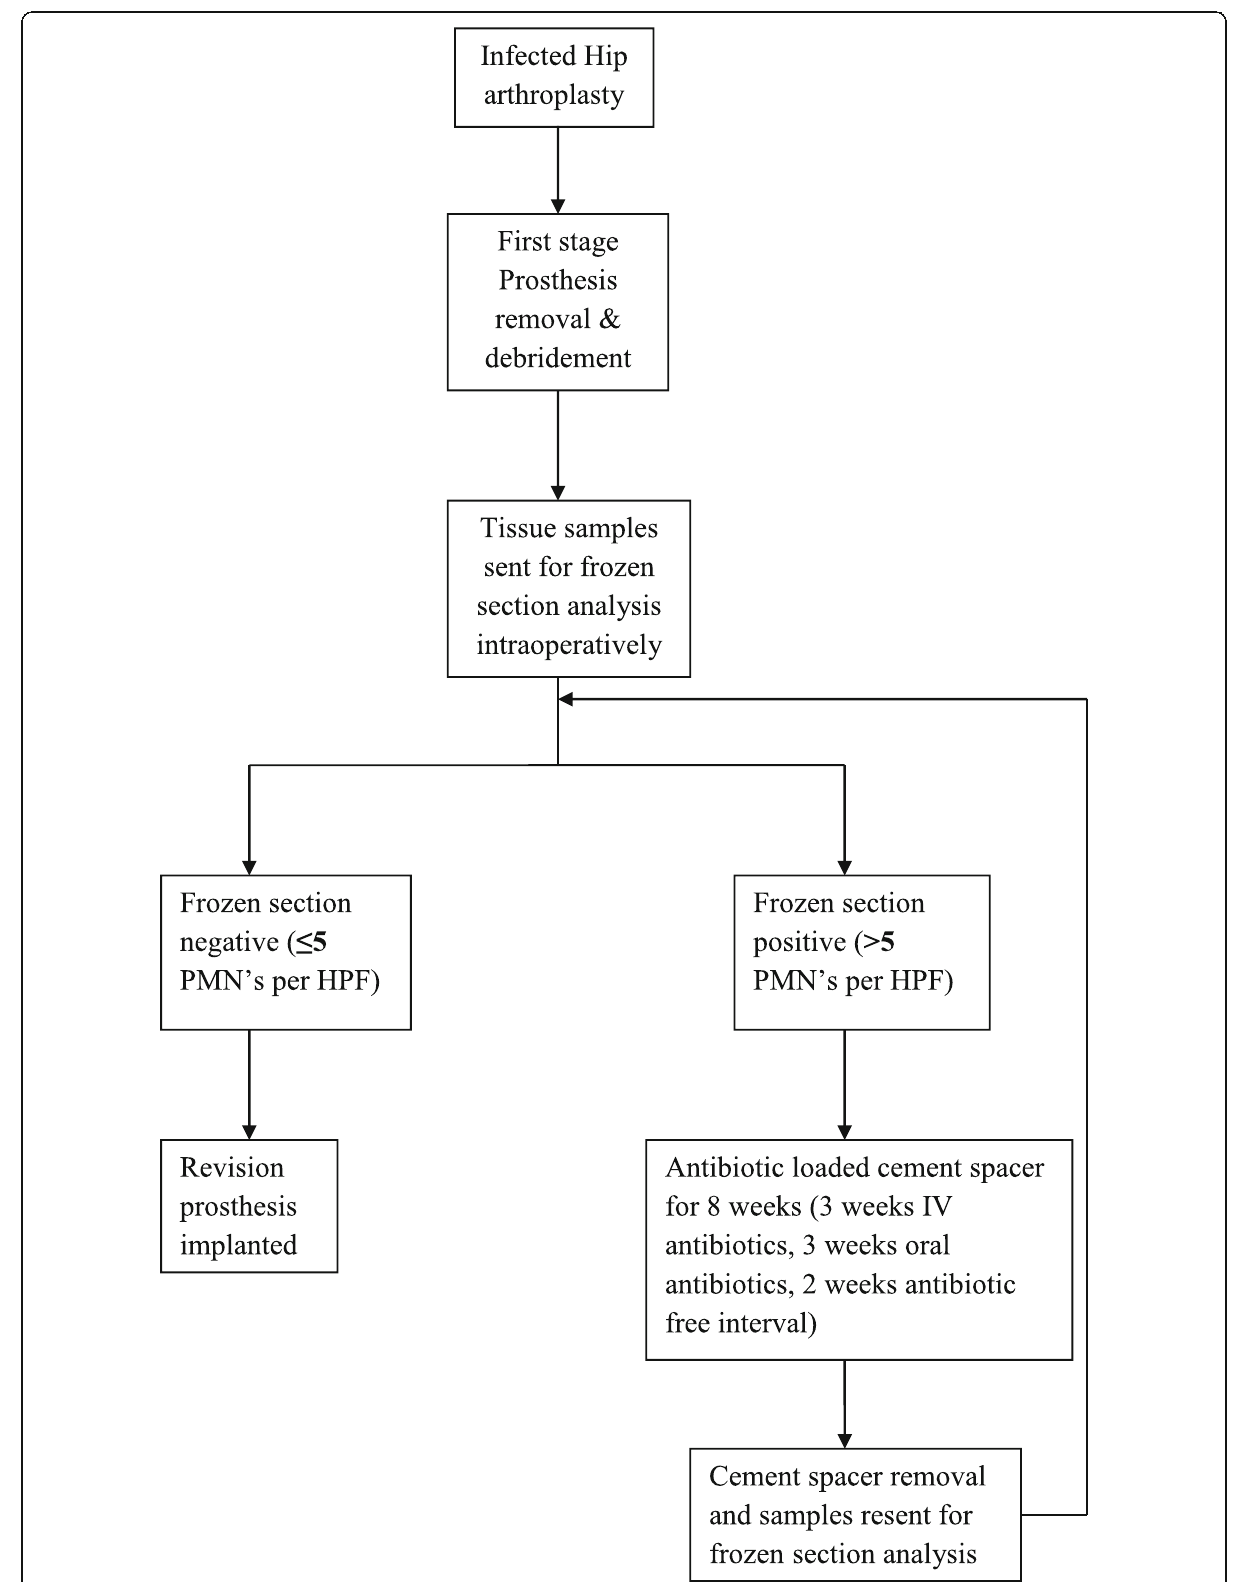
Fig. 1 Operative